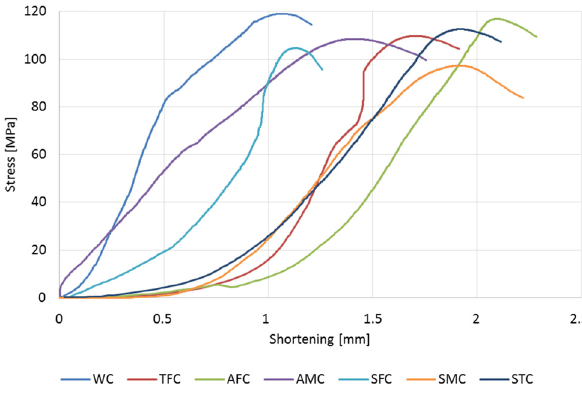
Figure 7: Example courses of compressive strength tests.